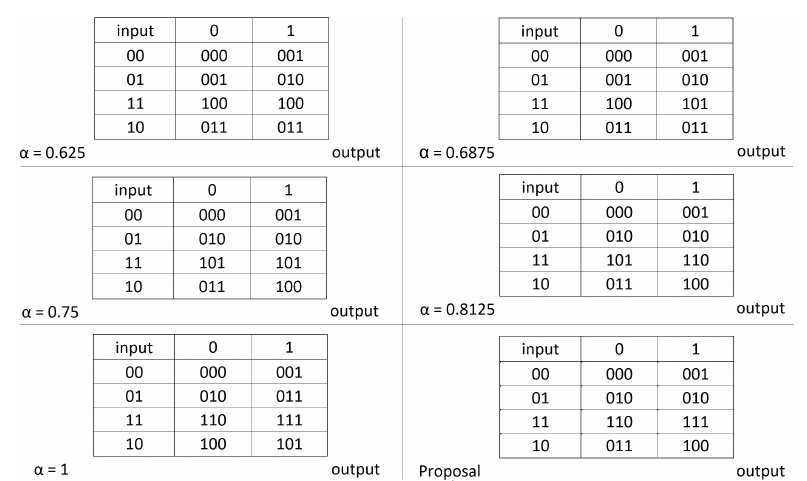
Figure 9. Karnaugh maps for several α parameters and 4-bit